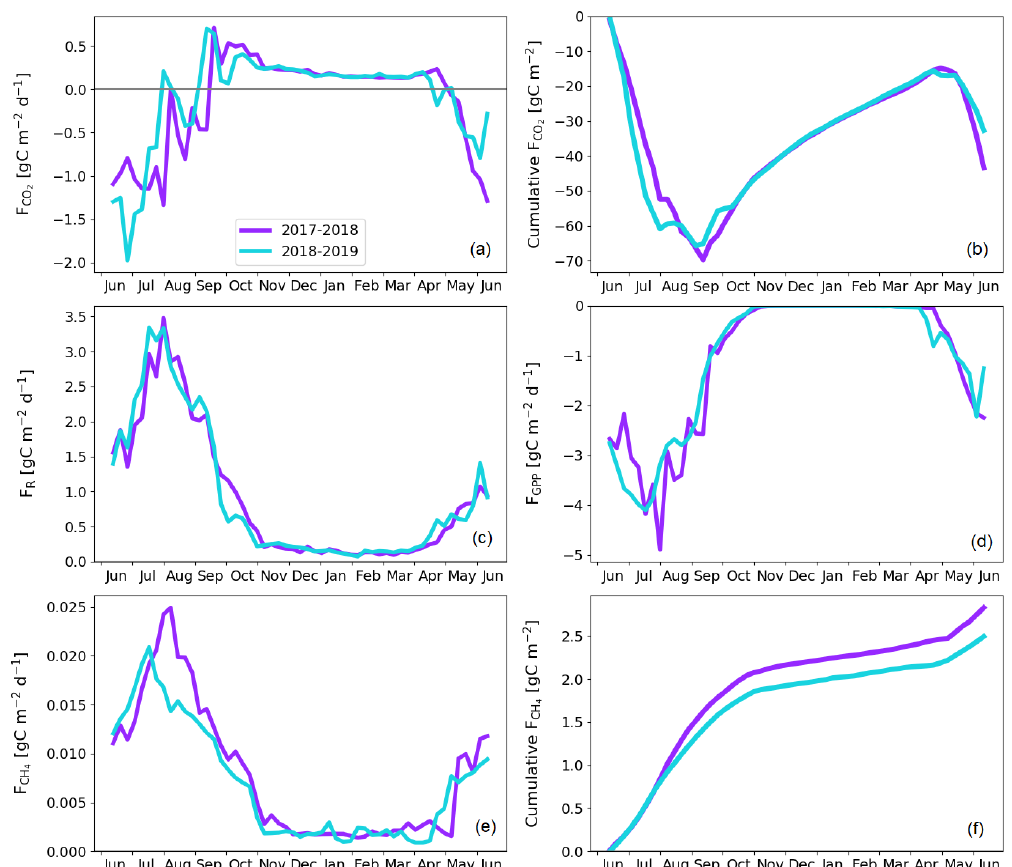
Figure 13. Landscape-level gap-filled fluxes. Weekly averaged CO 2 (a) , ER (c) , GPP (d) , and CH 4 (e) flux. Cumulative CO 2 (b) and CH 4 (f)